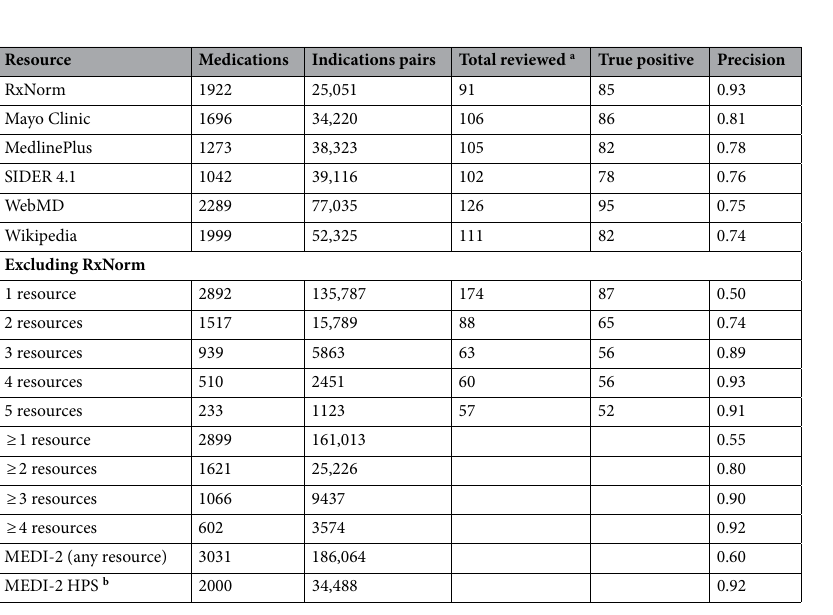
Figure 3. Weighted Venn diagram of distribution of medication-indication pairs within the six resources for MEDI-2, stratified by ICD-9-CM (left) and ICD-10-CM (right). Each colored area represents a different resource. The larger number in each colored area represents the number of medications found in the combination of resources labeled by the smaller numbers in the parenthesis. The numbers in the parenthesis correspond with the numbers in the color legend. The circle area sizes are proportional to the number of medications–indications that were found within the corresponding resource(s). ICD International Classification of Diseases.